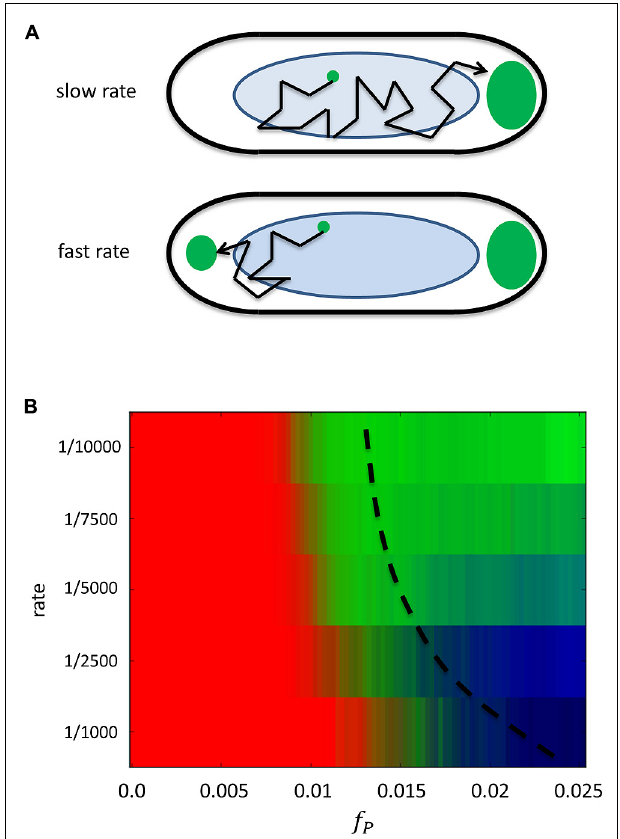
FIGURE 2 | Predicted dependence of localization on the addition rate of protein. (A) Schematic of the model for polar localization.Top cell has a slow rate of protein addition where the existing aggregate will tend to capture all added proteins.The bottom cell has a fast rate of addition, so that not all proteins will be captured, leading to the possible formation of another polar aggregate. (B) The calculated probability of observing a particular localization pattern as a function of the amount of protein f P , in the cell at different rates of addition. Each row corresponds to a given rate of addition and protein is added to the cell leading to a monotonically increasing amount with time ( x -axis).Thus each row represents the temporal evolution of the localization pattern as protein is added at the given rate up to some final amount. At slow rates of addition (rate < 1/7500), the pattern transitions from diffuse (red) at low amounts of protein to unipolar (green) at higher amounts. At faster rates of addition (rate > 1/2500), the pattern transitions from diffuse to bipolar (blue) at higher concentrations. Also shown is a hypothetical dashed line for the final value of f P , if protein is only added for the same amount of time at each